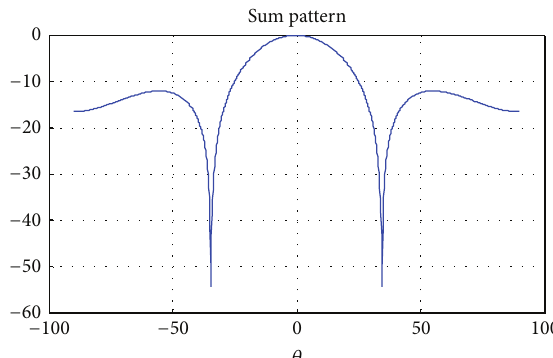
Figure 1: Sum beam pattern for the 10-element linear array for 𝑢 = 1 .